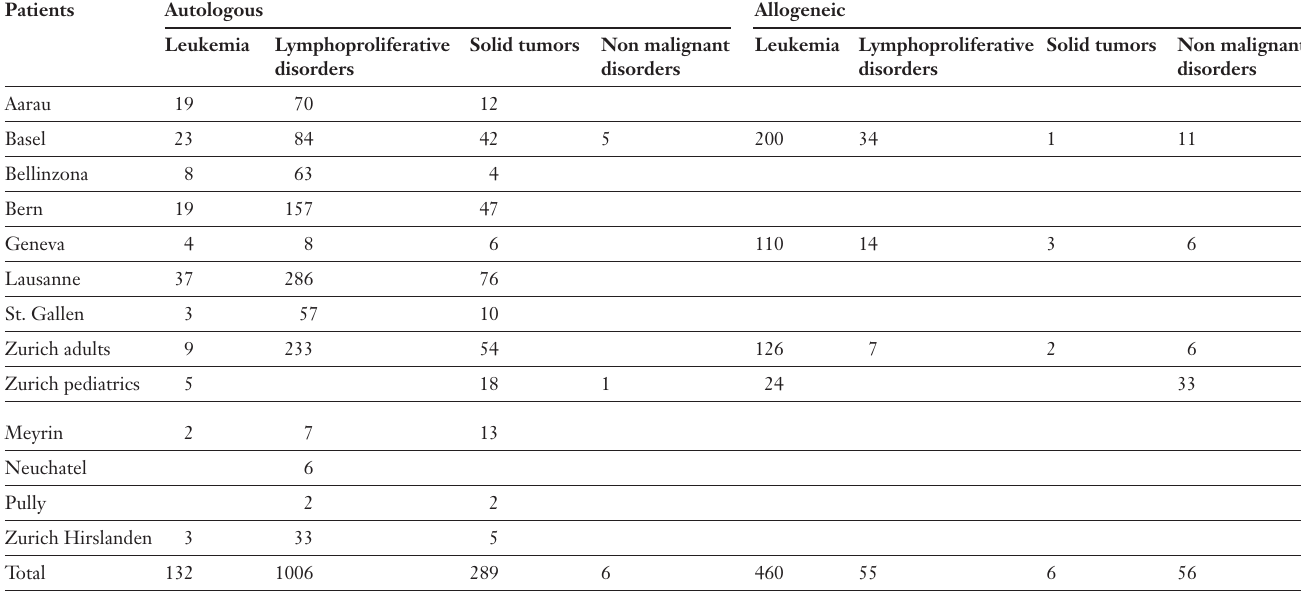
Numbers of patients with a first HSCT in Switzerland from 1997–2003 by centre and main